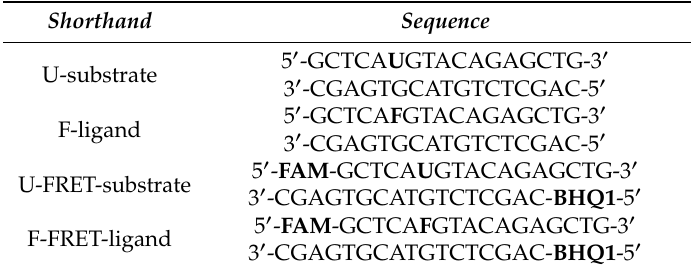
Table 1. DNA duplexes used as substrates and ligands of hSMUG1 a